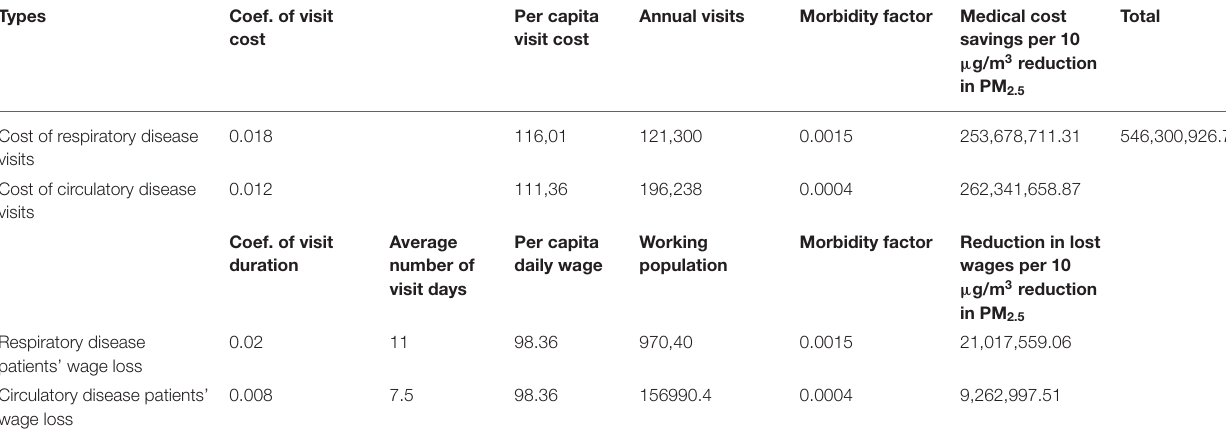
TABLE 8 | Health benefits of measured air quality